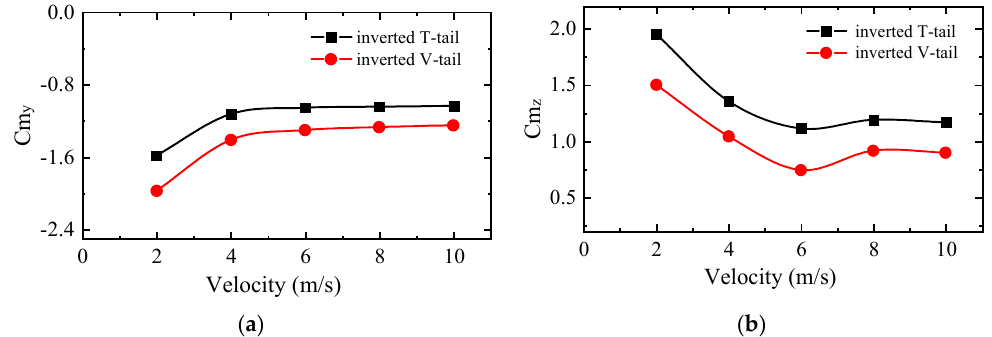
( c ) Figure 13. Moment coefficient at different angles of attack on tails. ( a ) Pitch moment coefficient. ( b ) Yaw moment coefficient. ( c ) Roll moment coefficient. In this section, the control moment characteristics under different inlet velocities are also discussed. The inlet velocity range was set as 0 m/s to 10 m/s, and the angle of attack was 0. The pitching moment coefficient decreased with increasing incoming flow velocity, as shown in Figure 14. When the incoming flow velocity was less than 4 m/s, the tail was significantly affected by flapping, and the pitching moment coefficient was larger than the